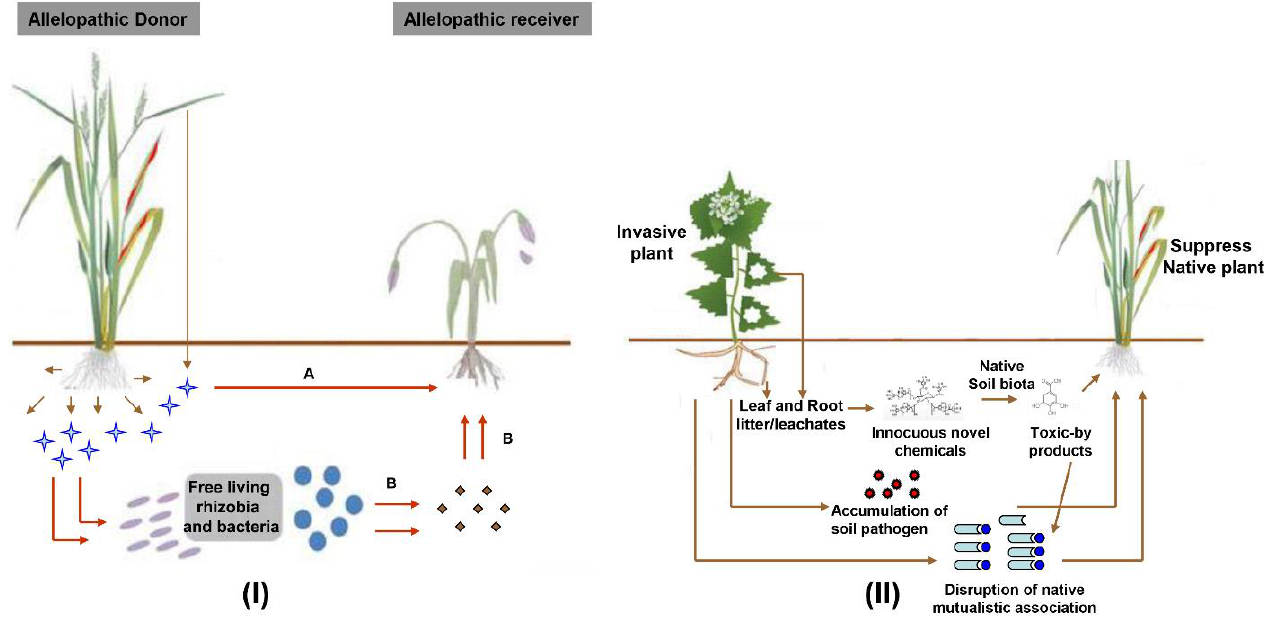
Figure 1. The concept of allelopathy and plant–soil interaction. ( I ) Donor plants release allelochemicals from their roots or decomposing leaf materials. Allelochemicals exert growth inhibitory activity on target plants either directly (A) or via the intermediate of soil microorganisms, which convert the plant-derived compound into a more active form (B); ( II ) Invasive plants might alter native plant–soil interactions by changing soil chemistry, the composition of soil-living symbiotic mutualists, or the abundance of local pathogens.